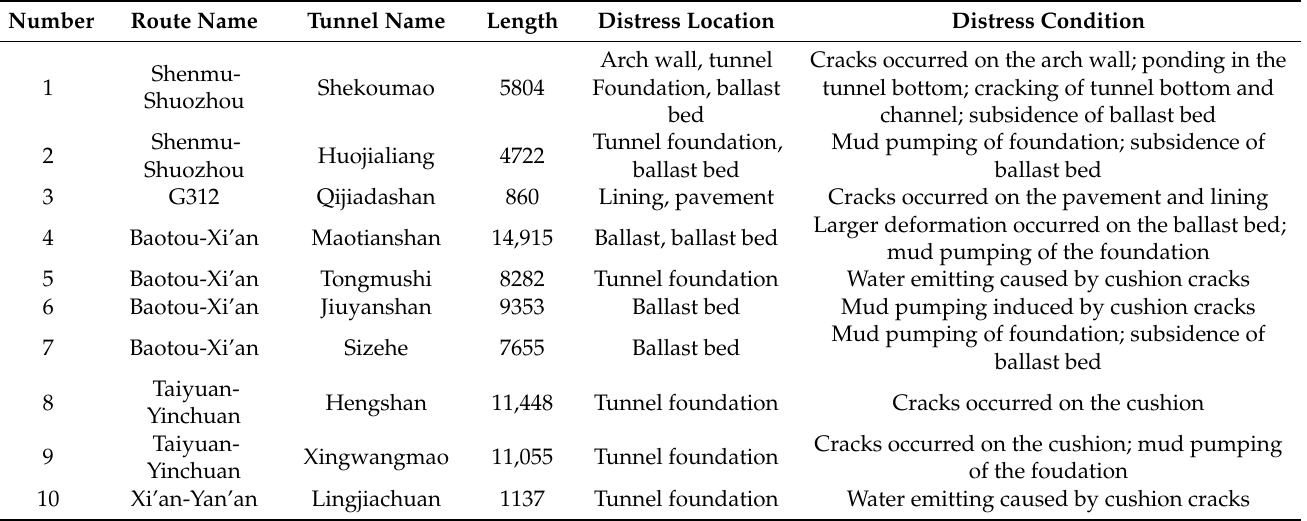
Table 1. Statistics of diseases at the bottom of some operating loess tunnels in China